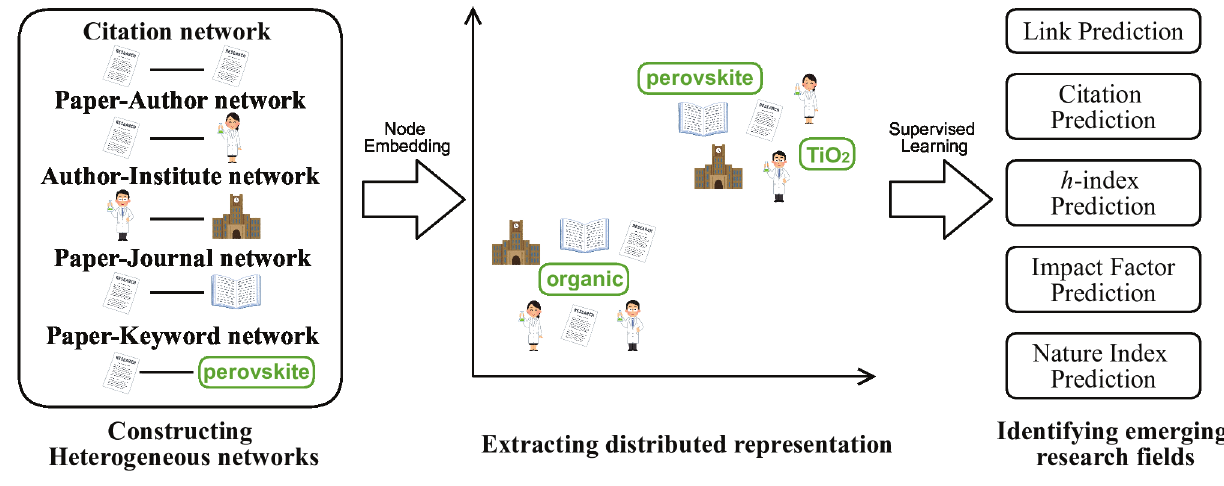
Fig 1. Outline of the